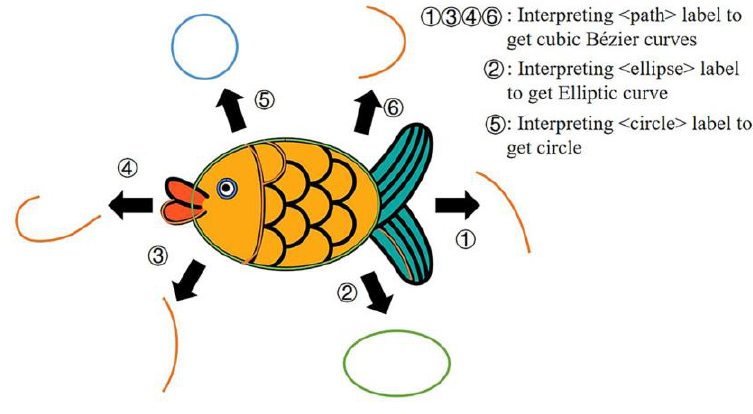
Figure 4. Constitution of a carp SVG as an example.